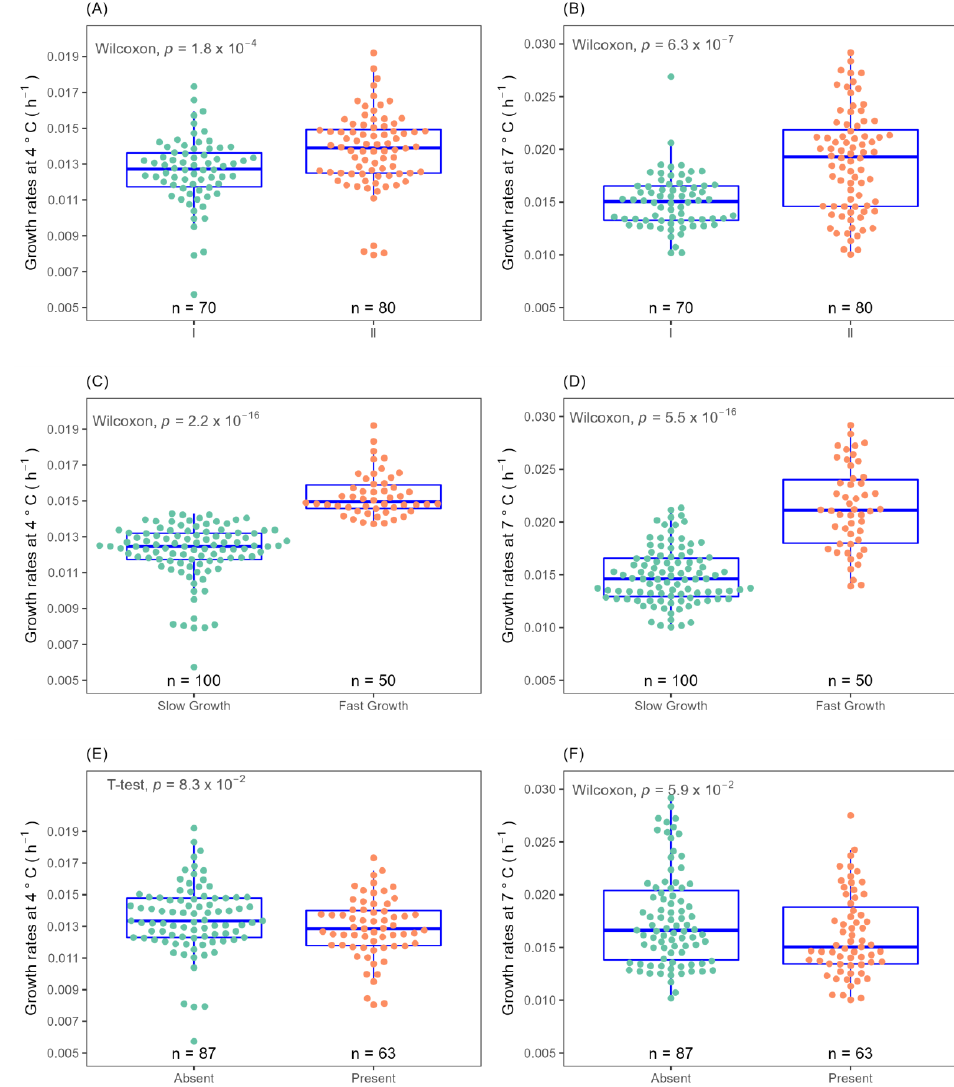
Figure 1. Isolates clustered by optical density determined growth rates at 4 and 7 °C according to lineage I (green); lineage II (orange) ( A , B ), hierarchical cluster slow growth (green); fast growth (orange) ( C , D ) and absence of plasmid (green); presence of plasmid (orange) ( E , F ).